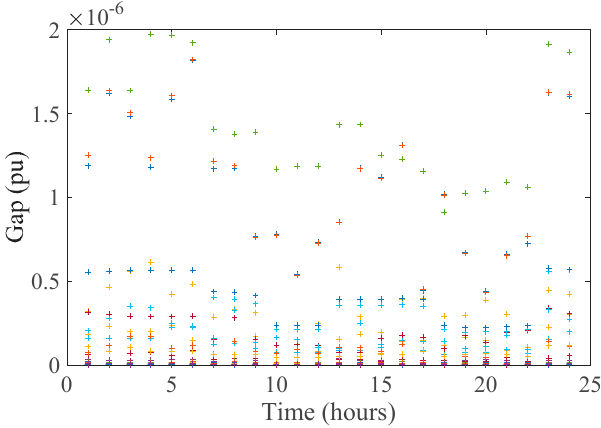
Figure 12. Scatter diagram of relaxation error of 69-bus distribution network.